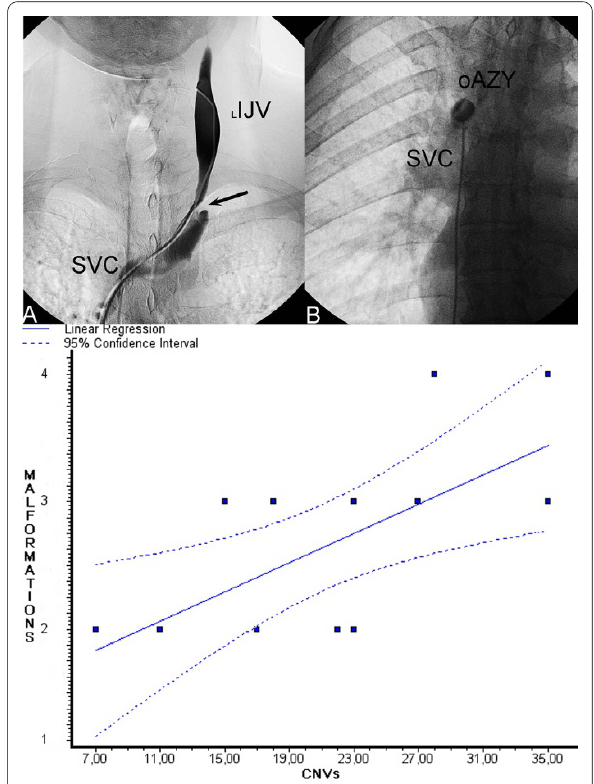
Figure 2 Stenosing venous malformation associated to MS and genotype-phenotype correlation . Top Panel: Exemplification of stenosing venous malformation associated to MS. Significant stenosis (arrow) of the left internal jugular vein (L IJV). B) Membranous obstruc- tion of the outlet of the azygous vein (o AZY) into the superior vena cava (SVC). Bottom Panel) Linear regression analysis. A significant cor- relation between the number of CNVs and the number of venous mal- formations detected by means of selective venography was found (r = 0.6577, p =